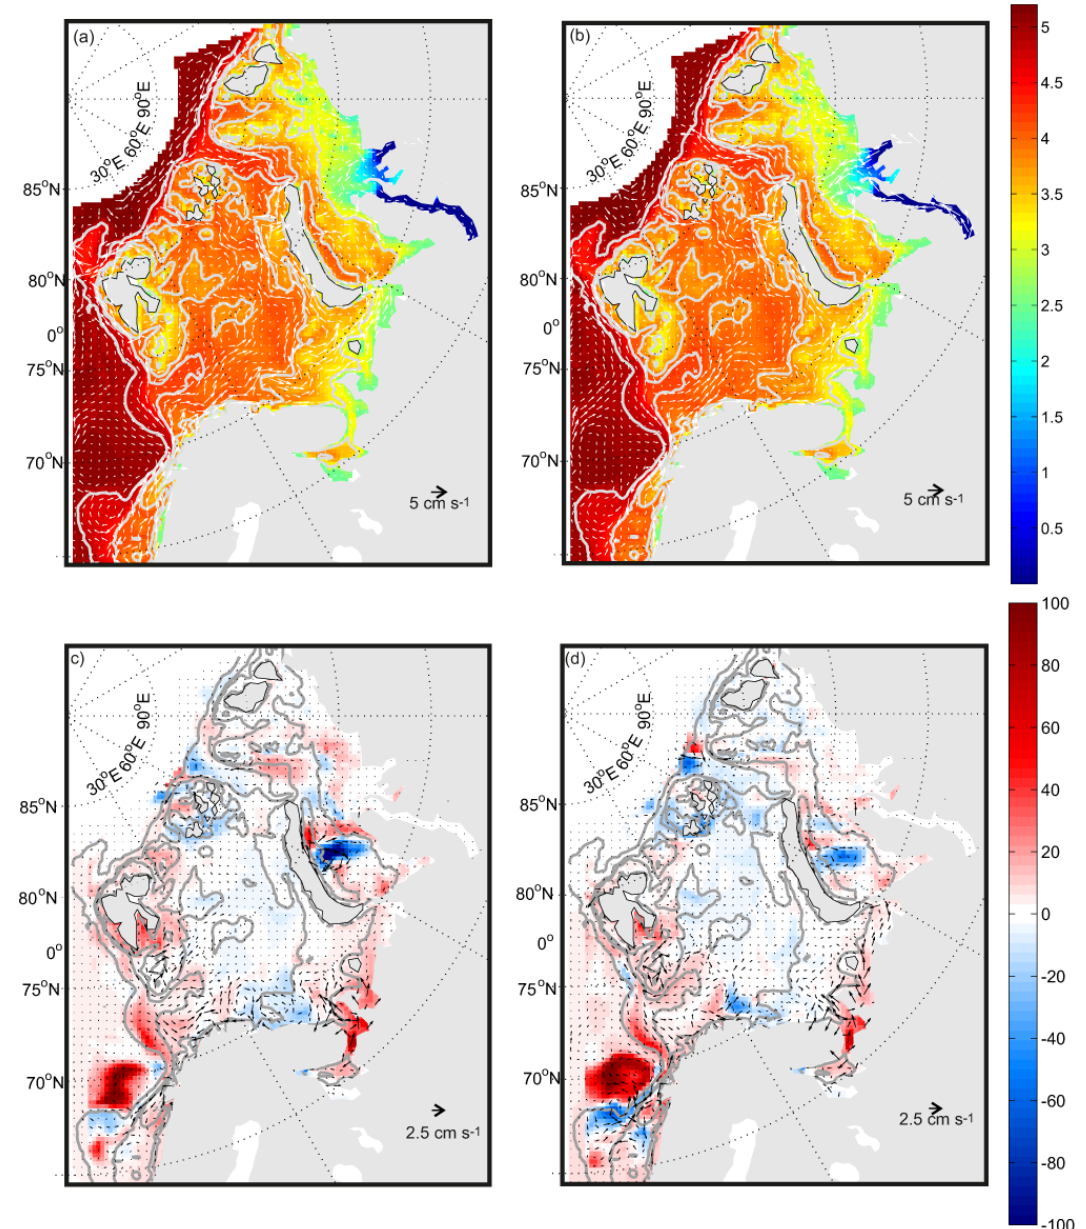
Fig. 9. Vertically integrated salt content (kgm − 2 , color contours on a logarithmic scale) and barotropic velocities (arrows) for (a) summer and (b) winter from the fifth year of integration of the control model run (without tides). The velocity vectors are capped at 5cms − 1 . The difference in vertically integrated salt content (kgm − 2 , color contours) and barotropic velocities (arrows) between the model run with tides and the control run for (c) summer and (d) winter. The velocity vectors are capped at 2.5cms − 1